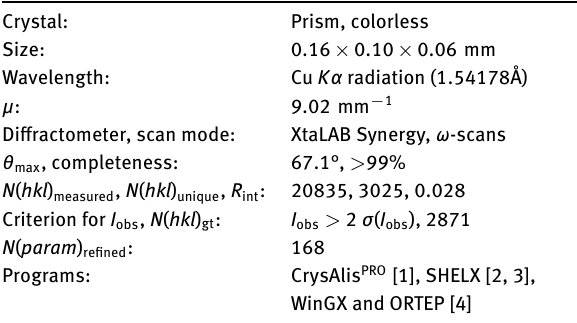
Table 1: Data collection and handling.